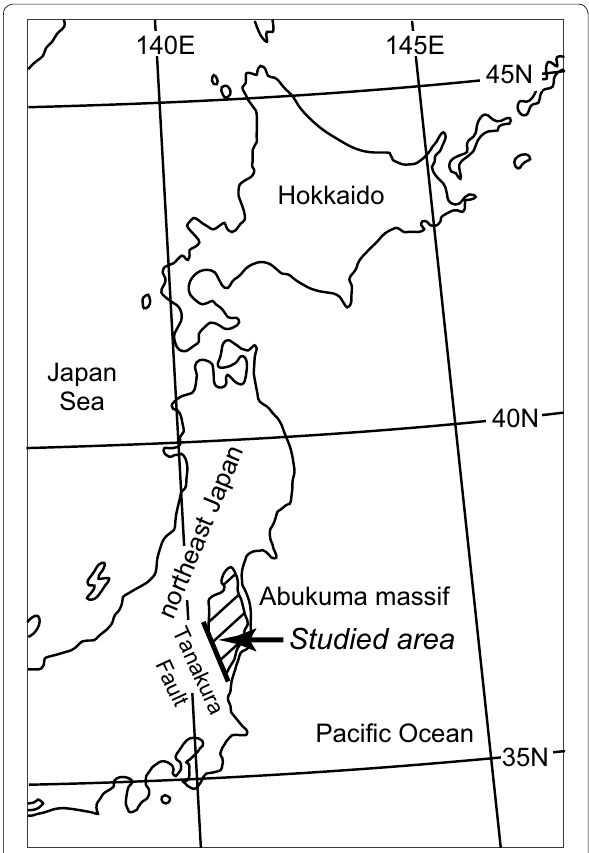
Fig. 1 Map of the Iritono granite in the Abukuma massif, northeast Japan (reproduced from Wakabayashi et al.